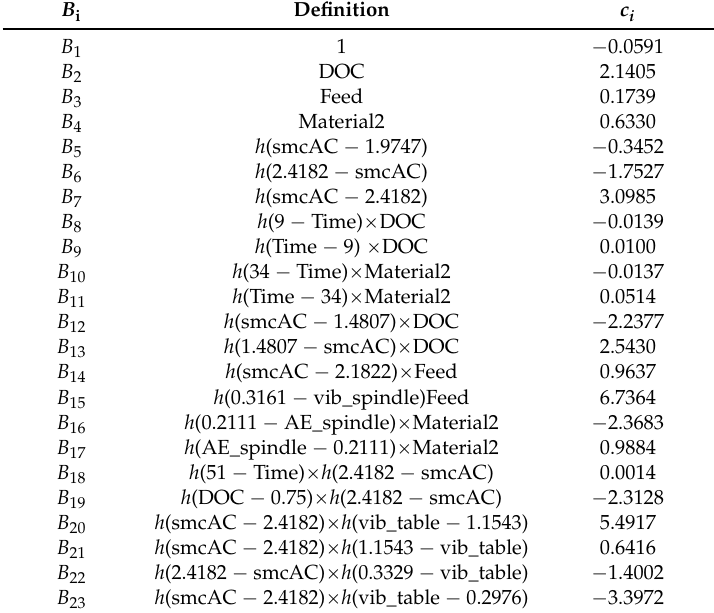
Table 6. List of basis functions of the best fitted ABC–MARS–based model for the tool flank wear (VB) and their coefficients c i